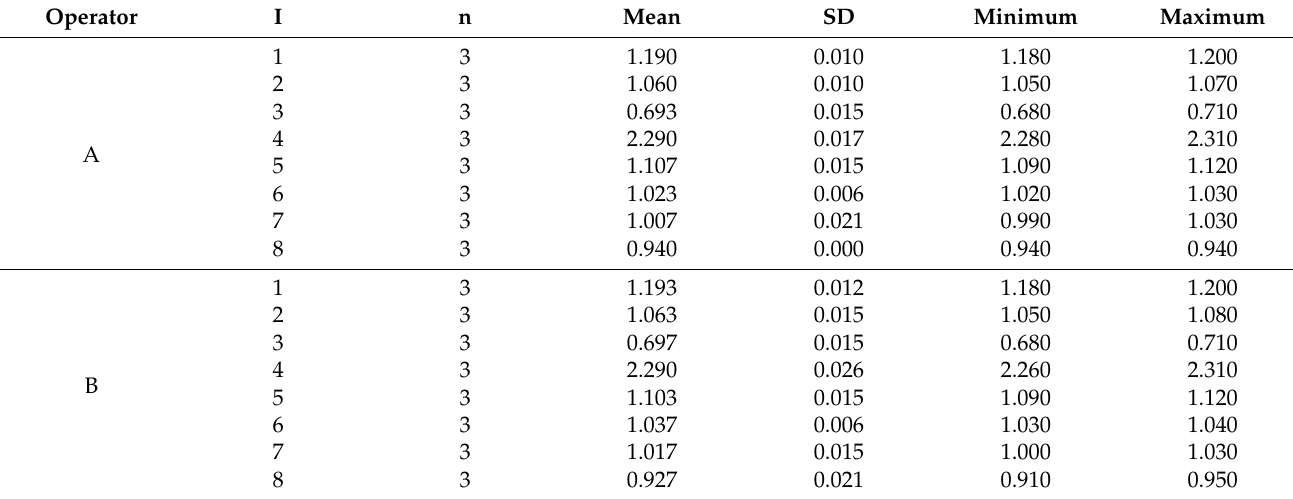
Table 1. Descriptive statistics of the area of the volume of the palatine suture expansion through palatine rapid maxillary expansion technique between operators.